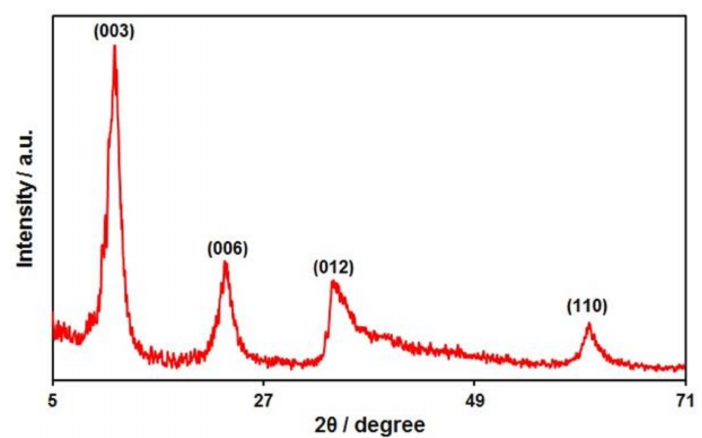
Figure 2. XRD pattern of Ni-Co LDH hollow structures.